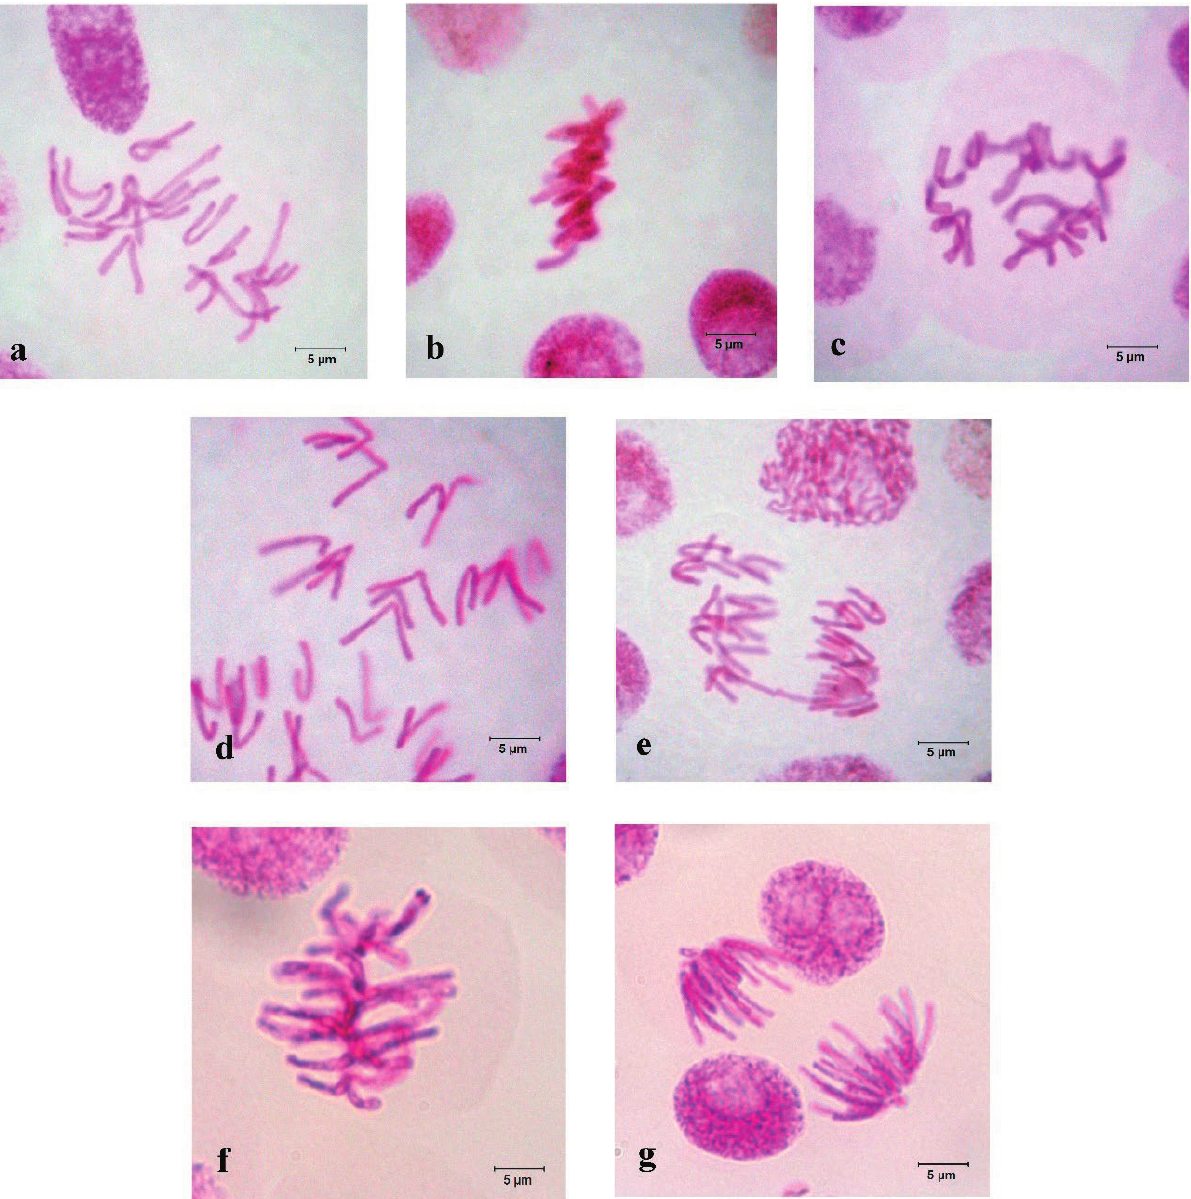
Figure 1. Chromosome aberrations in Allium cepa root meristem cells after treatment with extracts of Gypsophila species. a: Disturbed met- aphase ( G. perfoliata var. araratica -24 hours-5.000 mg/ml); b: Sticky metaphase ( G. pilosa -24 hours-2.500 mg/ml); c: c-metaphase ( G. per- foliata var. araratica -24 hour-5.000 mg/ml); d: Disturbed anaphase ( G. perfoliata var. perfoliata -48 hours-5.000 mg/ml); e: Anaphase bridge ( G.osmangaziensis -24 hours-2.500 mg/ml); f: normal metaphase and; g: normal